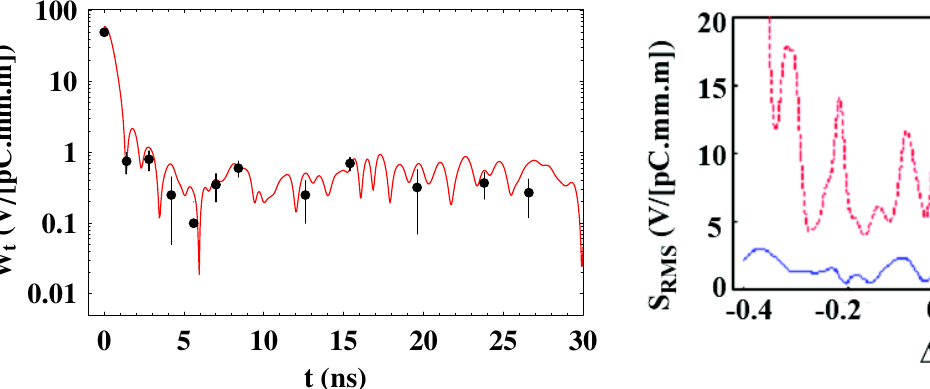
FIG. 12. (Color) Emittance dilution (illustrated by the red dashed curve) versus the percentage change in the bunch spac- ing. Also shown is the corresponding rms of the sum wakefield (by the solid blue curve).